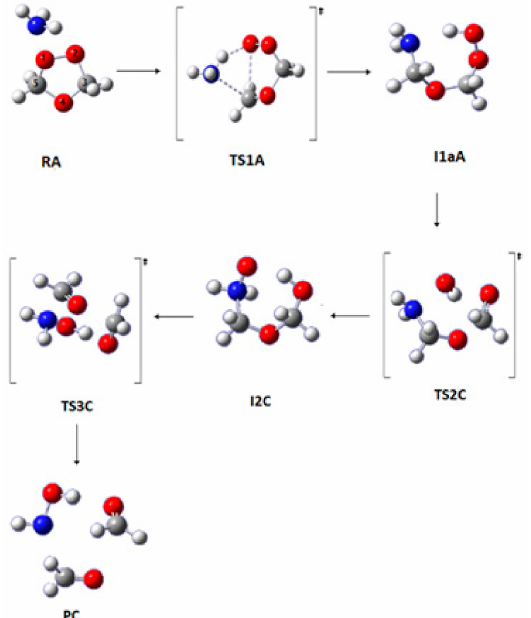
Figure 4. Optimized geometries for the stationary points in Pathway C of the reaction between SOZ and ammonia. Calculated at the APFD / 6-311 ++